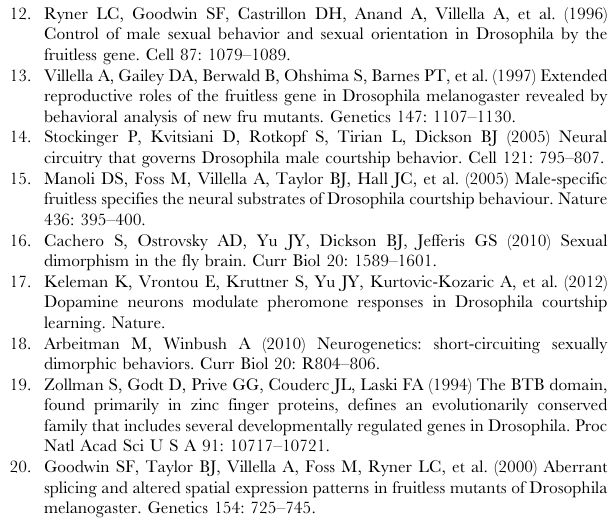
Figure S5 Consensus sequences of TRA/TRA-2 binding sites. Consensus sequences of TRA/TRA-2 binding sites of D. melanogaster , An. gambiae and Ae. aegypti dsx , fru and dsx + fru genes obtained with WebLogo web tool. The absence of a consensus is clear for mosquitoes genes. Figure S6 Graphical representation and list of motifs identified by MEME analysis. Schematic graphical represen- tation and tabular list of the motifs identified by MEME analysis in Aeafru and Aeadsx genes. (PDF) Methods S1 Lists of primers, GenBank accession numbers and web tools utilized in this paper. Table S1 Modified Censor output of repetitive elements identified in Aeafru intronic regions. The identified repetitive elements greatly vary in length and among them the most abundant are the NON-LTR/Jockey LINE-1_AA element [86], detected in 38 copies, and the NON-LTR/SINE Feilai elements [87], detected in 36 copies. Table S2 Ae. aegypti intron analysis. Tabular output of Aedes aegypti intron analysis. The average number of repetitive elements per kb (indicated as NoRE/kb) in Aeafru introns is 2,03 6 0,28 while the average percentage of nucleotides of the identified repetitive elements with the respect to the nucleotides of the Aeafru introns (indicated as REbp) is 34,56% 6 19,54 (Fig- ure S1). To compare these values with the average values of the Ae. aegypti introns, we analysed 1000 randomly chosen Ae. aegypti introns (size range from 1 to 130 kb) with the CENSOR software, defining an average NoRE/kb (2,19 6 0,68) and REbp (47,22 6 17,75%) intron values for this species. This analysis indicates that within the introns of Ae. aegypti the number of repetitive elements per kb is almost constant, with a value of about 2, while the size of these elements is variable, ranging from 30% to 60% of the whole intron sequences. The NoRE/kb and REbp values of the Aeafru introns do not deviate significantly this observation.